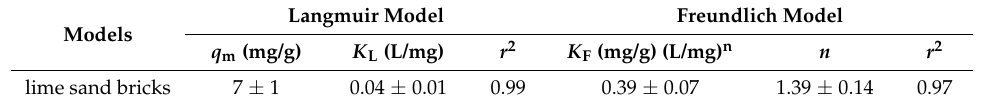
Table 4. The parameters of Langmuir and Freundlich isotherms for the adsorption of Cu(II) by lime sand bricks.